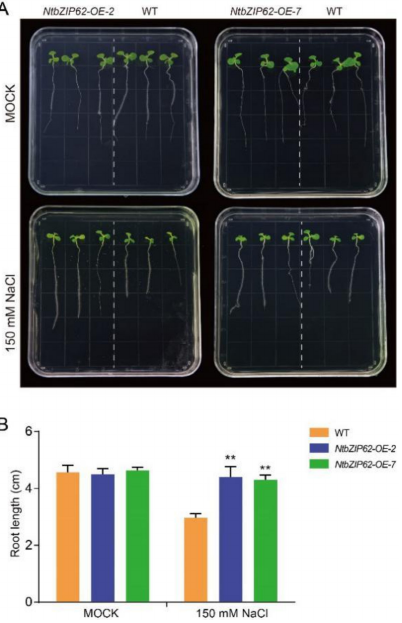
Figure 9. Effect of NaCl treatment on root growth of NtbZIP62 transgenic lines. ( A ) Root growth of wild type and NtbZIP62 overexpression lines under 0 or 150 mM NaCl treatment. ( B ) The quantification of primary root length on medium and the data were retrieved from more than 15 plants per genotype with three biological replicates. WT, wild type. Values represent means ± SD. ** p < 0.01 ( t